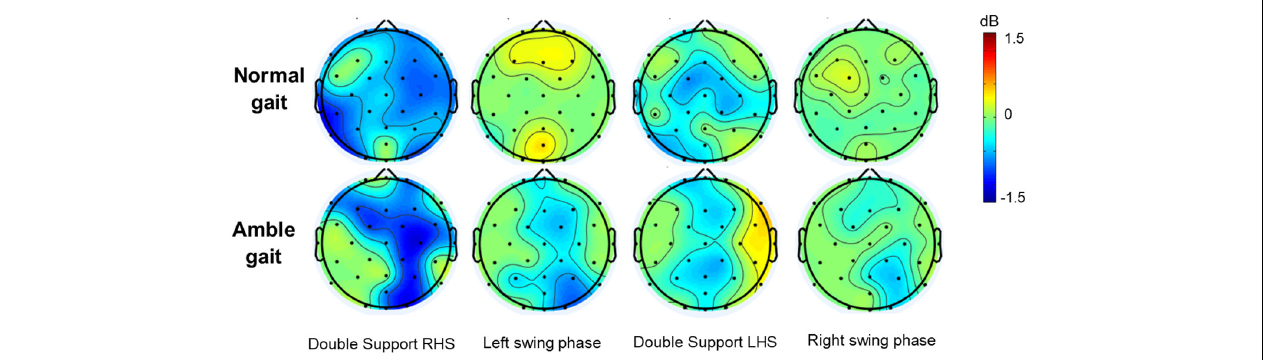
FIGURE 2 | Group averaged topographic distribution of event related spectral perturbations (ERSP) over the entire scalp (32 electrodes) during normal ( n = 35) and amble ( n = 19) gait in healthy participants. Significant ( p < 0.05) event related desynchronization is illustrated in blue and significant event related synchronization in